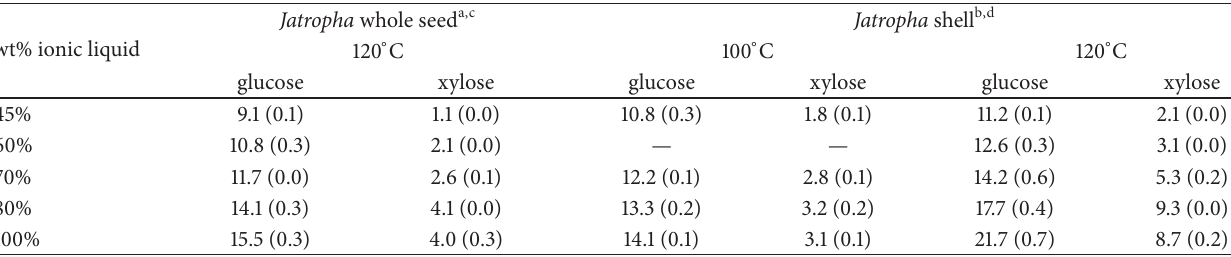
Table 4: Weight percent fermentable sugars (relative to weight of jatropha whole seed or jatropha shell) recovered from jatropha whole seed and jatropha shell pretreated with the cosolvent [C2mim][Ac]-MeOH at 100 and 120 ∘ C. wt% ionic liquid